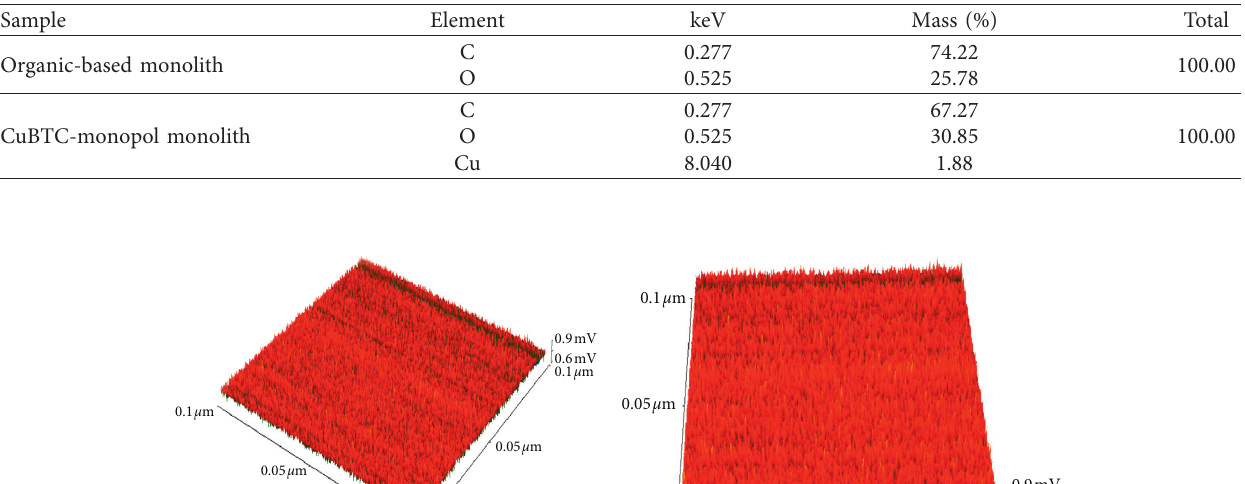
Table 1: Elemental composition of the fabricated materials determined by EDAX analysis.